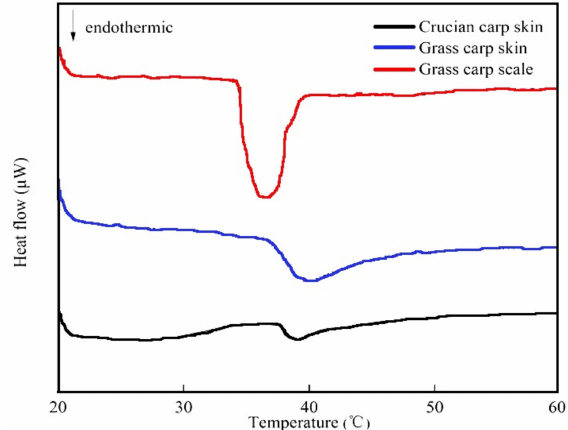
Figure 4. Di ff erential scanning calorimetry (DSC) thermogram of collagens from grass carp skin, scales and crucian carp